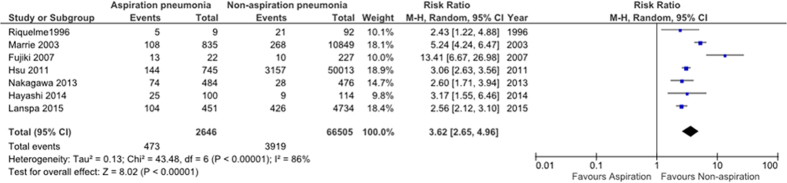
Pooled mean difference for in-hospital mortality with 95% confidence intervals for eligible studies.